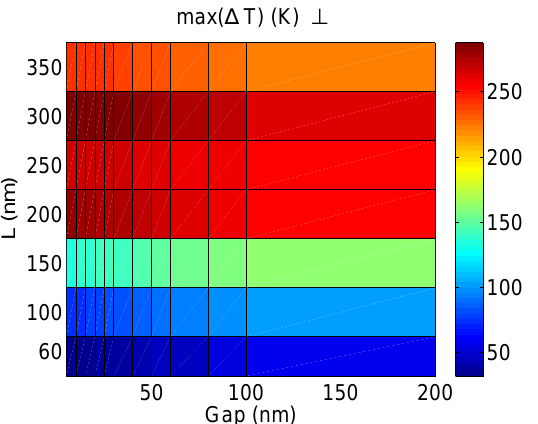
Figure 12: Maximum of elevation of temperature, ( K ) , as a function of the particle length L and the gap for perpen- dicular polarization